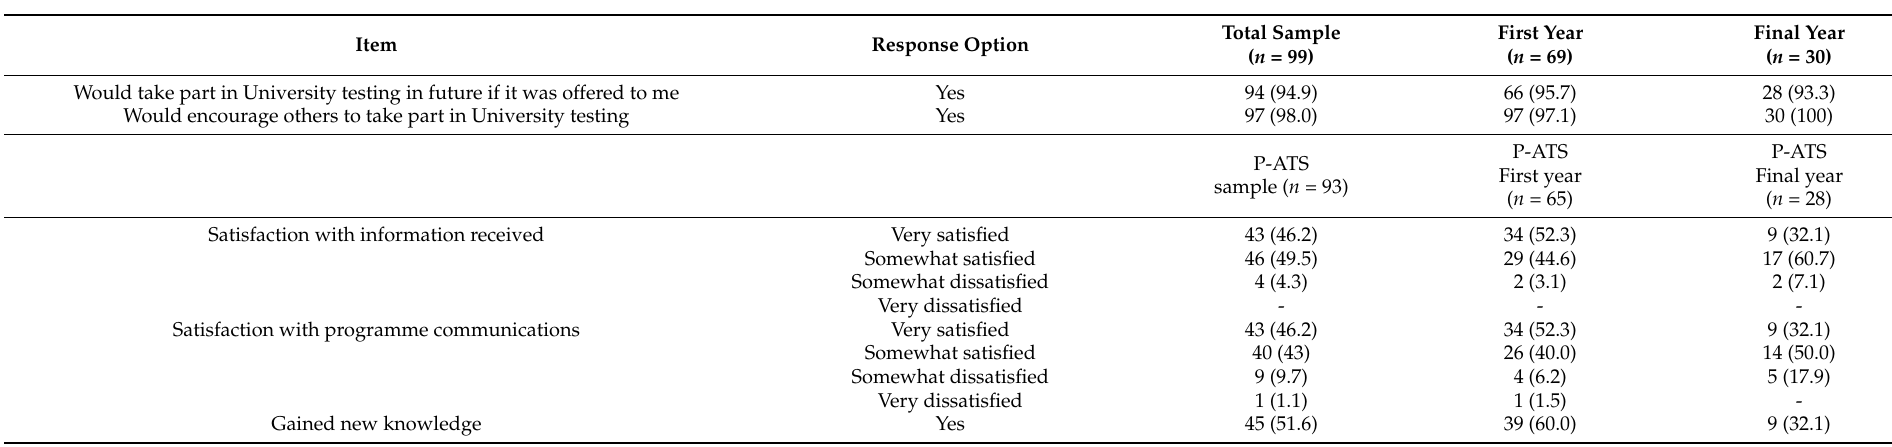
Table 5. Overview of satisfaction with P-ATS and uptake of future testing services